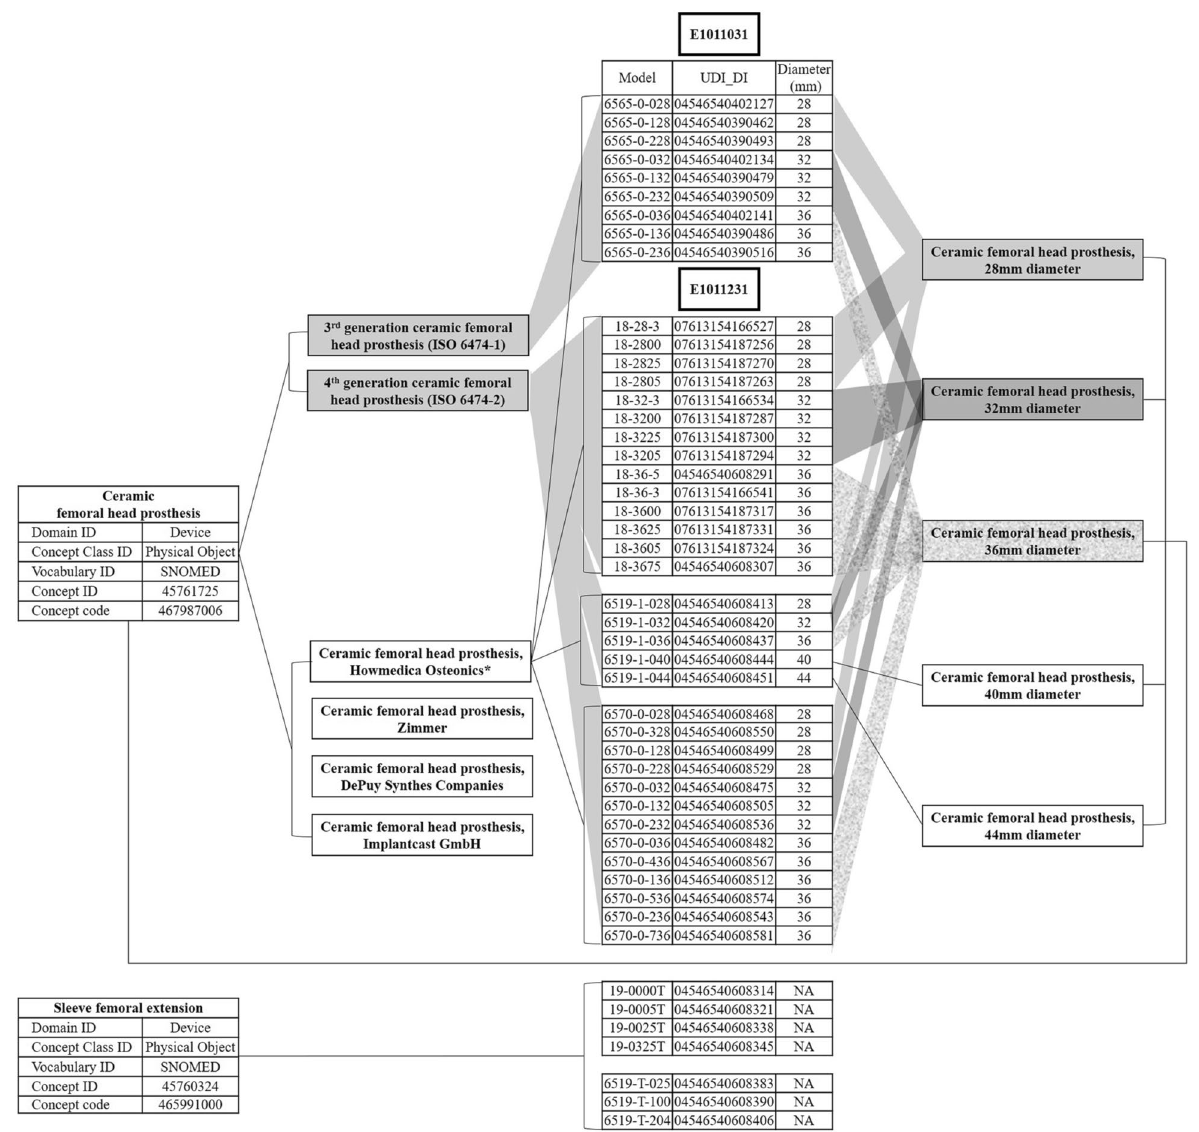
Figure 6. Ceramic femoral head hierrarchy was applied to Stryker’s products registered with national insurance EDI codes E1011031 and E1011231. EDI electronic data interchange, SNOMED systematized nomenclature of medicine clinical terms, UDI unique device identifier, DI device